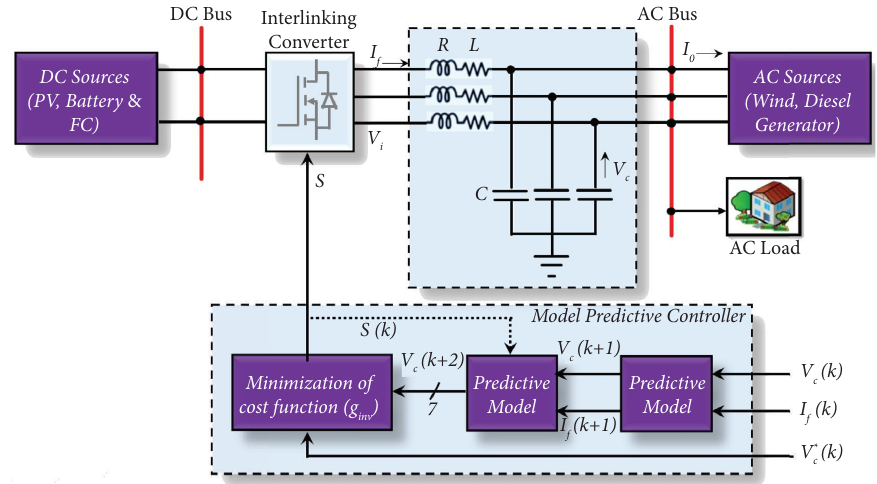
Figure 8: FCS-MPC scheme for interlinking